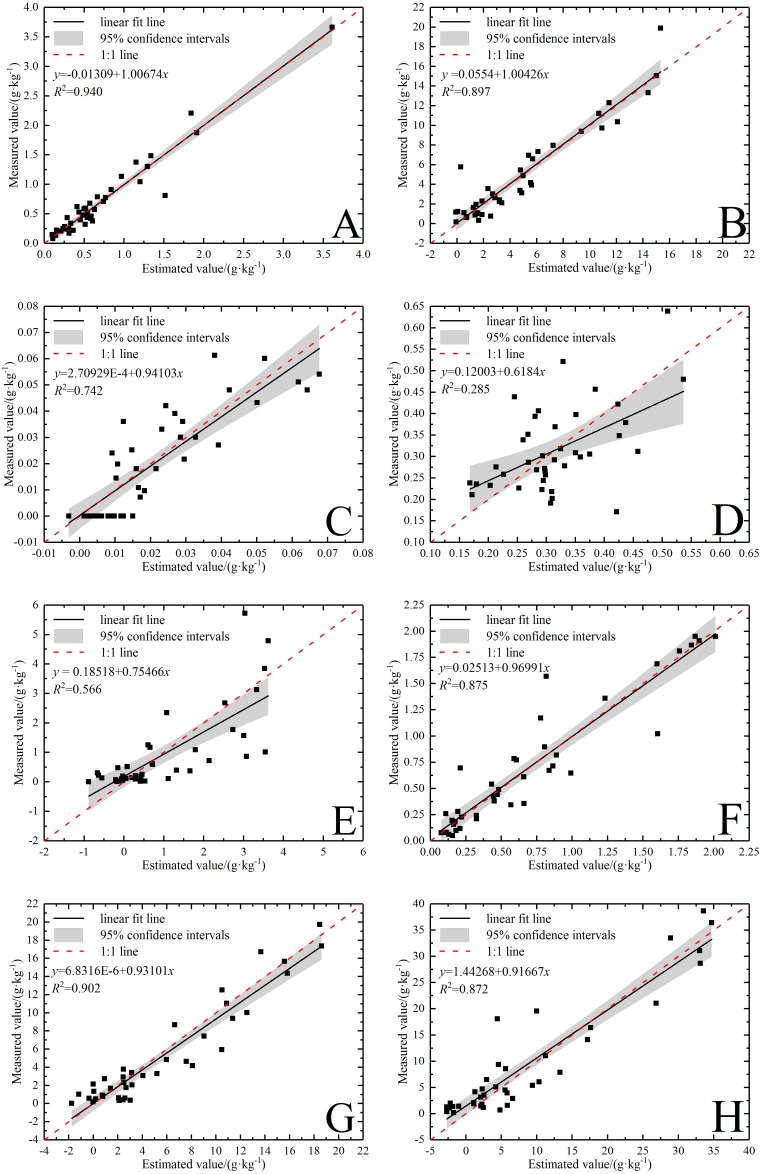
Validation of soil water-soluble salt ions content based on the best model.(A) Ca2+ with SR-SVR model. (B) Cl− with VIP-SVR model. (C) CO\documentclass[12pt]{minimal}
\usepackage{amsmath}
\usepackage{wasysym}
\usepackage{amsfonts}
\usepackage{amssymb}
\usepackage{amsbsy}
\usepackage{upgreek}
\usepackage{mathrsfs}
\setlength{\oddsidemargin}{-69pt}
\begin{document}
}{}${}_{3}^{2-}$\end{document}32− with SR-PLSR model. (D) HCO\documentclass[12pt]{minimal}
\usepackage{amsmath}
\usepackage{wasysym}
\usepackage{amsfonts}
\usepackage{amssymb}
\usepackage{amsbsy}
\usepackage{upgreek}
\usepackage{mathrsfs}
\setlength{\oddsidemargin}{-69pt}
\begin{document}
}{}${}_{3}^{-}$\end{document}3− with GC-PLSR model. (E) K+ with VIP-PLSR model. (F) Mg2+ with SR-SVR model. (G) Na+ with VIP-PLSR model. (H) SO\documentclass[12pt]{minimal}
\usepackage{amsmath}
\usepackage{wasysym}
\usepackage{amsfonts}
\usepackage{amssymb}
\usepackage{amsbsy}
\usepackage{upgreek}
\usepackage{mathrsfs}
\setlength{\oddsidemargin}{-69pt}
\begin{document}
}{}${}_{4}^{2-}$\end{document}42− with VIP-PLSR model.